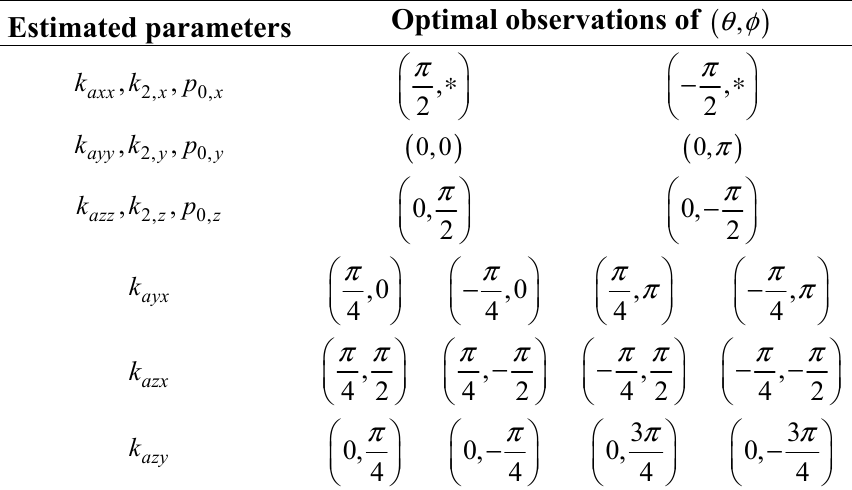
Table 2. The optimal observations for estimating calibration